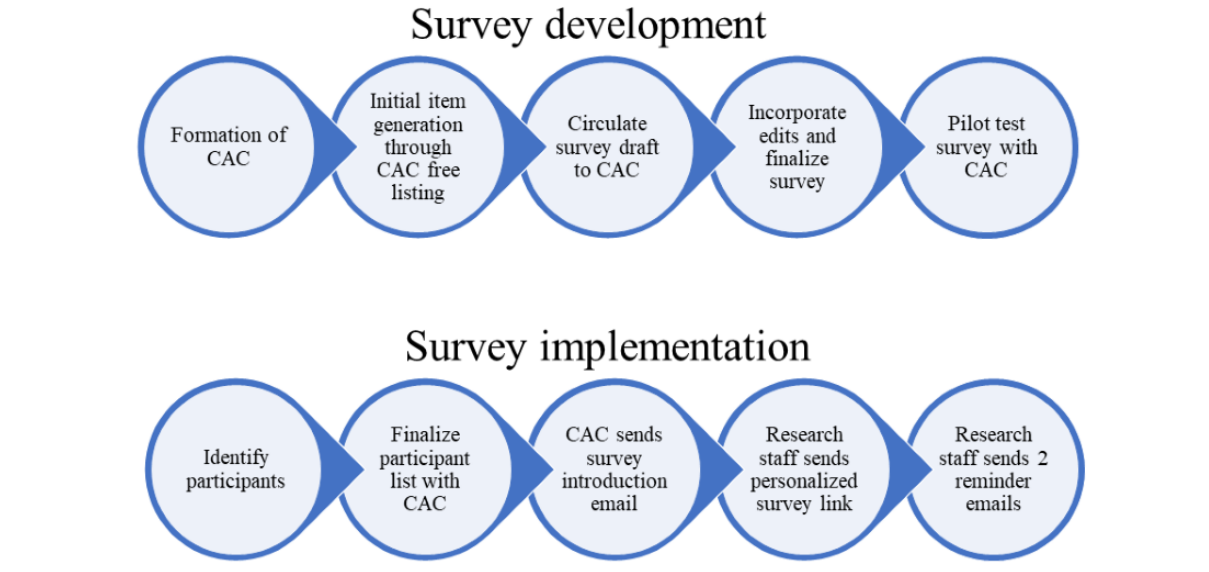
Figure 3. Regional Health Equity Survey development and implementation flow chart. CAC: community advisory